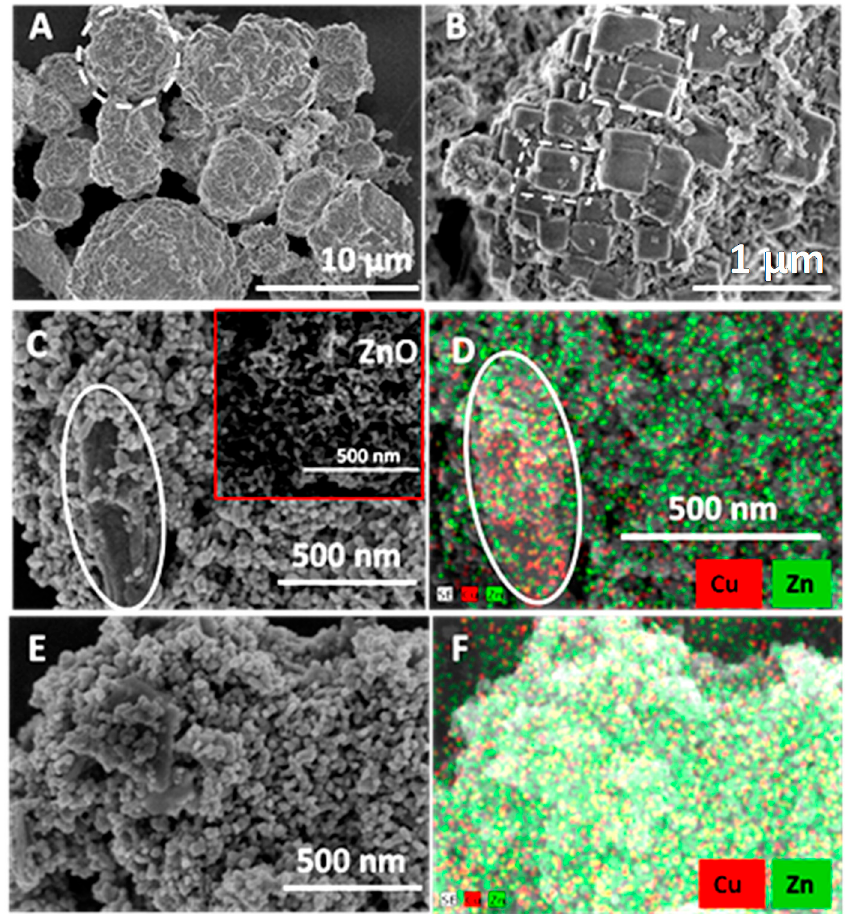
Figure 4. SEM images of ZnO-M composites. ( A , B ) Cu 2 CO 3 (OH) 2 ; ( C , D ) ZnO-M (0.5%); ( E , F ) ZnO-M (2.5%).